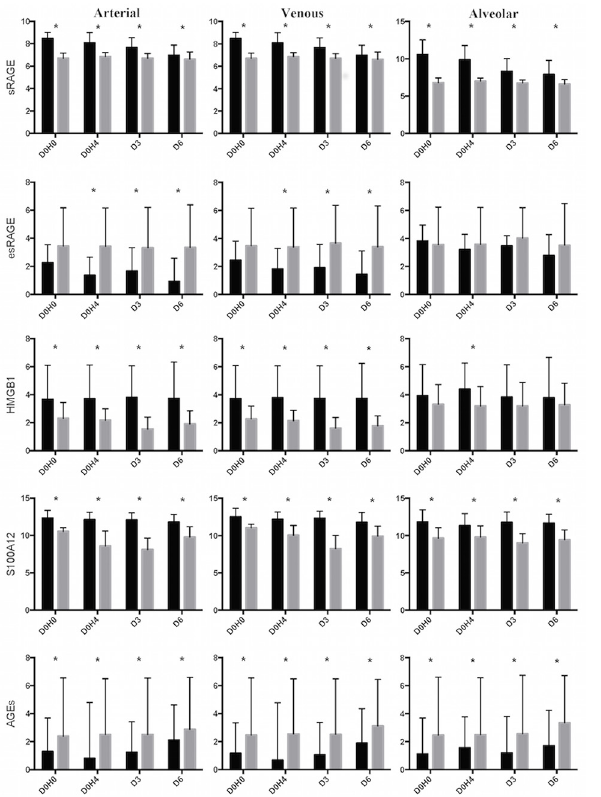
Fig 1. Log-transformed arterial, central venous and alveolar levels of sRAGE (in pg/ml), esRAGE (in ng/ml), HMGB1 (in ng/ml), S100A12 (in pg/ml) and AGEs (in μ g/ml) in patients with ARDS (black bars) and controls over time (grey bars). D0H0: inclusion; D0H4: 4 hours after inclusion; D3: day 3; D6: day 6). Values are reported as means ± standard deviations. * P < 0.05 between